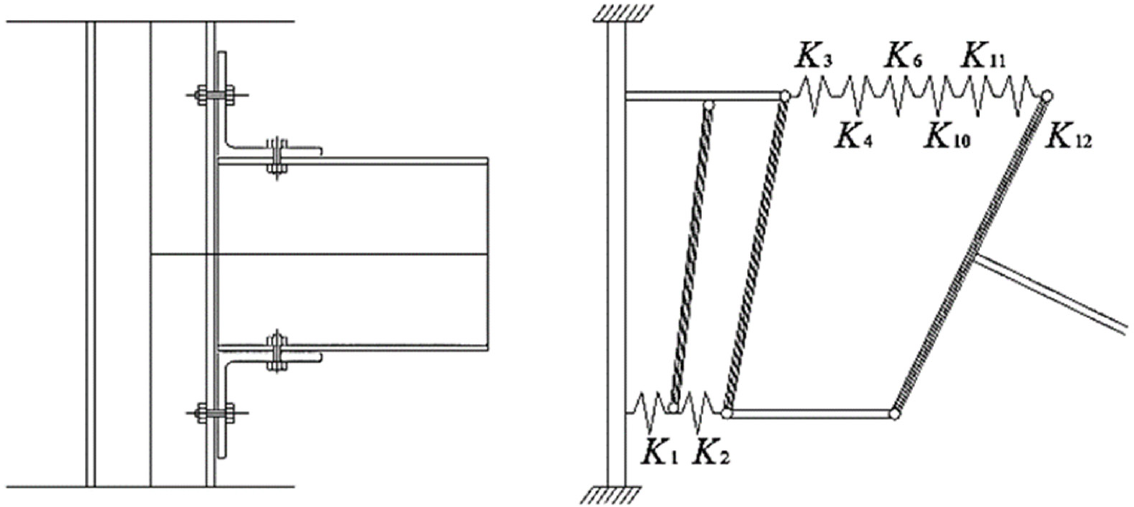
Figure 3. Component-based modeling of TSAC.